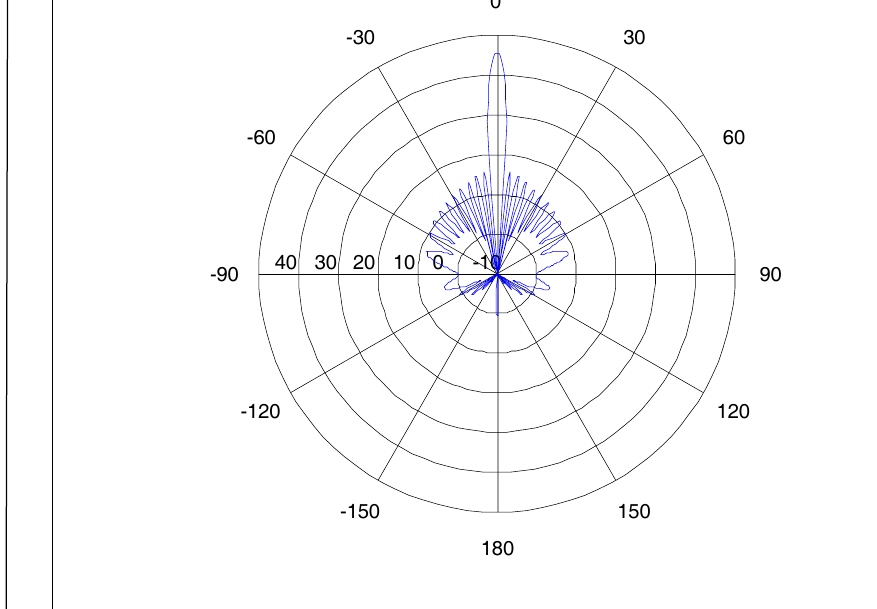
Na slici 2 prikazan je dijagram zra č enja antene radara TPS-63 u po- larnoj ravni. Sa ovog dijagrama vidi se celokupan izgled dijagrama zra č e- nja antene u azimutalnoj ravni. Gubici u sistemu Posebnu vrednost razvijenog ra č unarskog modela predstavlja mo- gu ć nost analize uticaja razli č itih gubitaka, u procesu radarskog osmatra- nja, na karakteristike radarskog sistema. Postoji nekoliko uzroka koji uti č u na smanjenje raspoložive energije signala na ulazu u prijemni kanal radara. To su [1]: